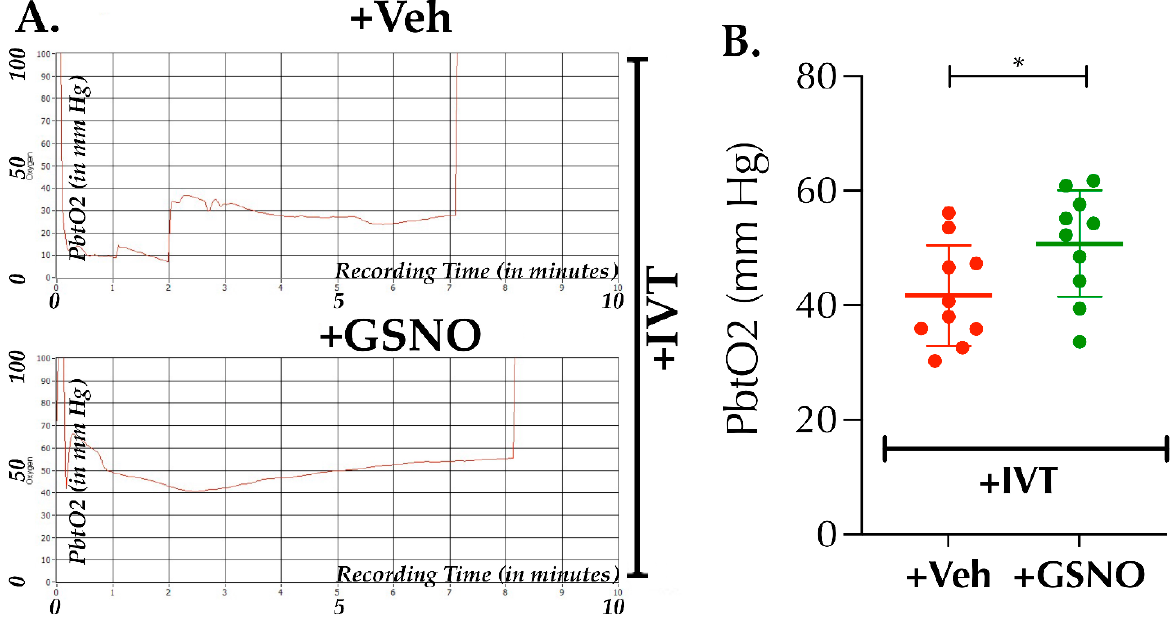
Figure 4. Nebulization of GSNO augments post-thrombolysis brain tissue oxygenation (PbtO2) at 6.5 h after stroke in diabetic mice. Diabetic male mice (C57/B6 background, 14 ± 1-wks. old) were subjected to PT-stroke and treated